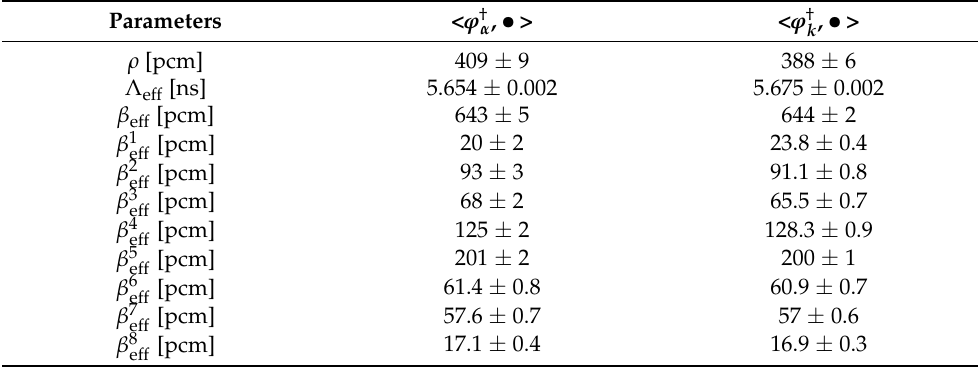
Effective kinetics parameters of Problem I, super-critical configuration including delayed contributions.